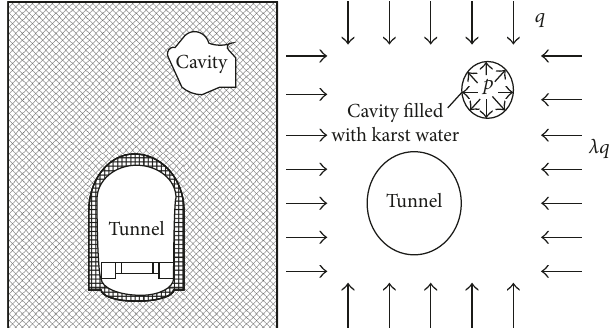
Figure 2: Position relationship of tunnel and concealed karst cavity and their simplified mechanical model.